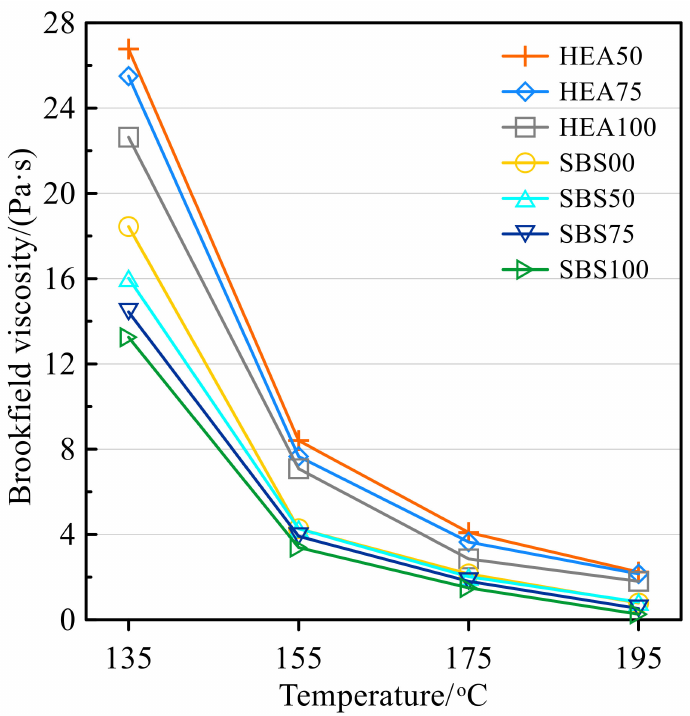
Figure 3. The viscosity of asphalt mastic at different